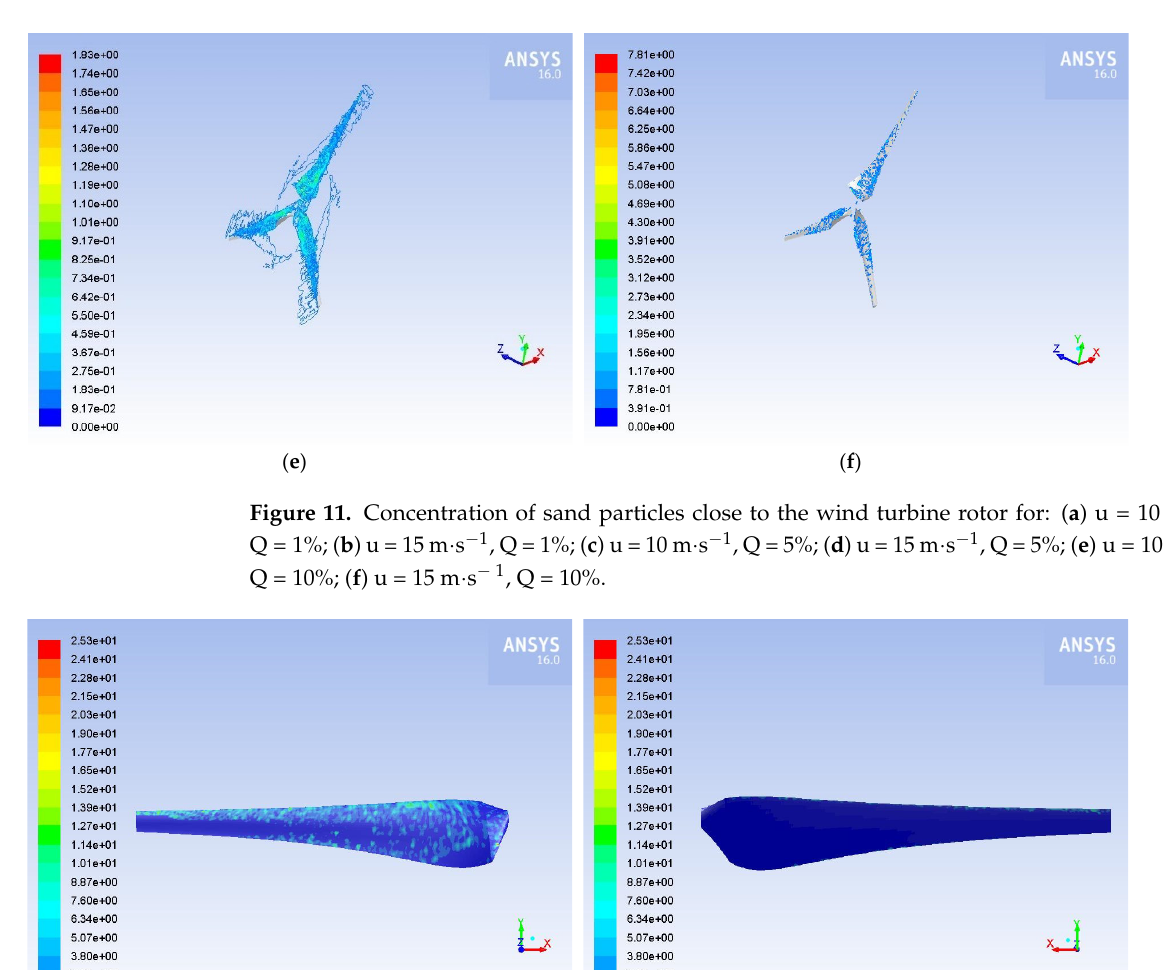
Figure 12. Particle dissipation rate on the blade’s ( a ) pressure and ( b ) suction side, for wind speed of 15 m·s − 1 and Q = 10%.